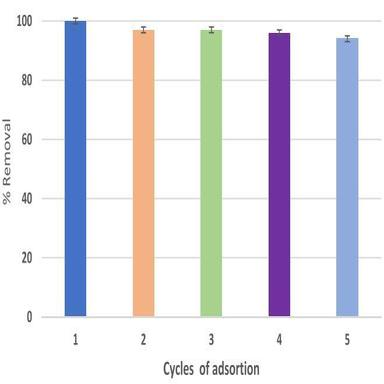
Adsorption studies capacities of the HC-g-AM-BIS-BT for MB after regenerated five times.